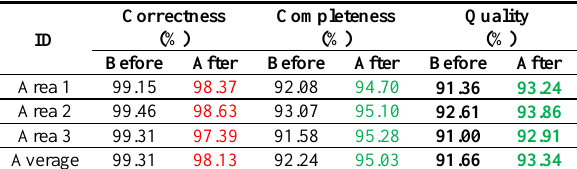
Table 1. The evaluation results before and after the